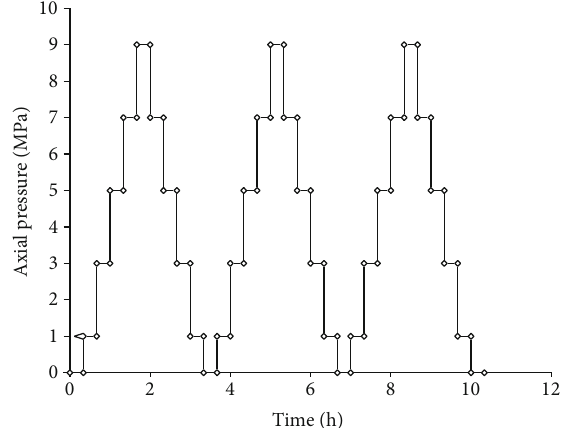
Figure 5: Cyclic loading-unloading path of axial stress for both sandstone and granite